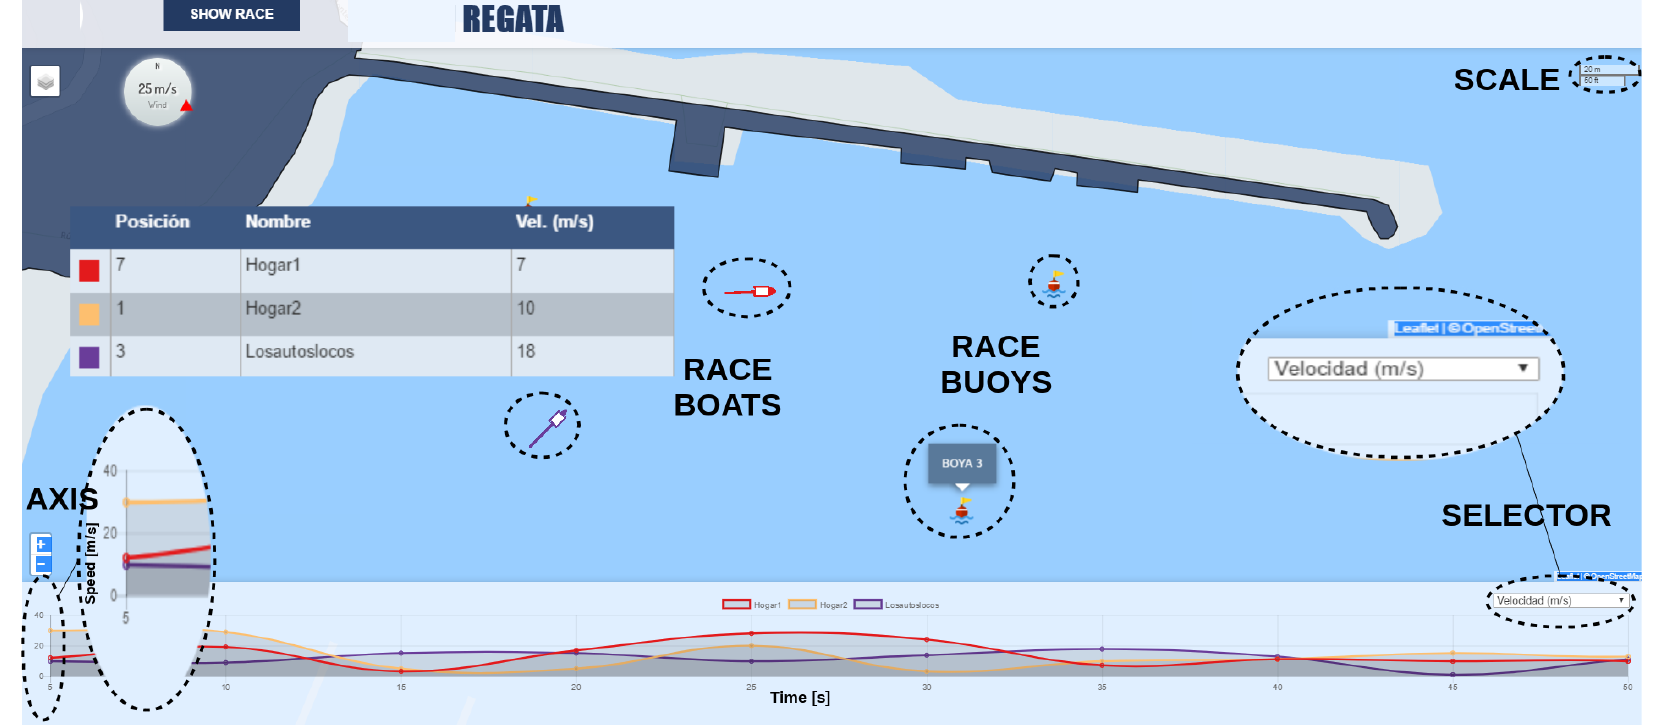
Figure 8. Dashboard for the online race